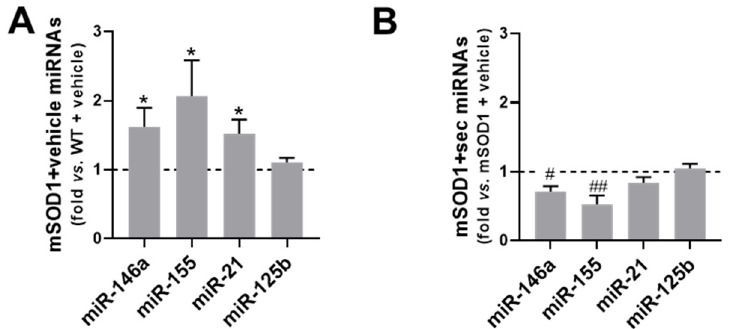
Figure 10. Upregulation of inflammatory-associated miRNA observed in the lumbar spinal cord (SC) of ALS mice is prevented by the secretome from the mSOD1 MNs engineered with anti-miR-124. Expression of inflammatory-associated micro(mi)RNAs (miR-146, miR-155, miR-21, miR-124, and miR-125b) in the SC of ( A ) SOD1-G93A (mSOD1) mice injected with the vehicle (basal media of NSC-34 motor neurons (MNs)) in comparison with those in wild-type (WT) animals, and ( B ) mSOD1 mice injected with the secretome derived from anti-miR-124-treated mSOD1 MNs (mSOD1 + sec) in comparison with those treated with the vehicle. The results were normalized to SNORD110. Data are expressed as fold change vs. ( A ) WT + vehicle and ( B ) mSOD1 + vehicle (mean ± SEM) from at least 5 animals per group. * p < 0.05 vs. WT + vehicle; ## p < 0.01 and # p < 0.05 vs. mSOD1 + vehicle, unpaired and parametric t -test (with Welch’s correction when needed).